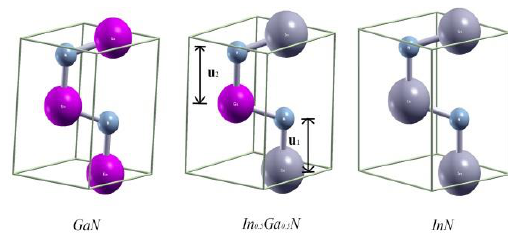
Fig. 1. Wurtzite structure of In spectively x=0, 0.5 and 1. The length bond In-N is u